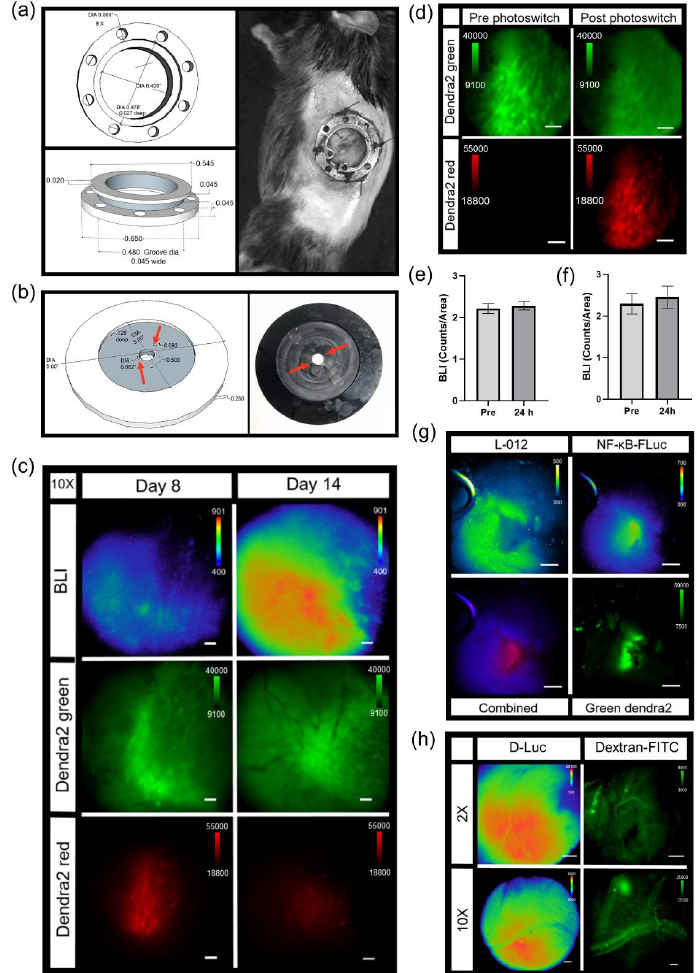
Figure 7. Intravital bioluminescence and fluorescence microscopy of pancreas window chamber. Diagram with measurements and representative photograph of ( a ) pancreas window chamber and ( b ) imaging stage insert. ( c ) Intravital microscopy images of the pancreas using wild type C57BL/6 abdominal window chamber-bearing animals with Pan02 NF- κ B-FLuc Dendra2 pancreatic tumors. Representative intravital image of NF- κ B-FLuc bioluminescence and Dendra2 fluorescence of Pan02 pancreatic tumor progression over time at 10X objective (BLI, 10 min acquisition, open filter; Dendra2 green, GFP cube, 200 ms exposure; Dendra2 red, DsRed cube, 500 ms; scale bar represents 100 µ m). ( d ) Representative fluorescence image of Pan02 tumor pre- and post-photoswitching (DAPI cube, 10 min exposure) at 10X objective (Dendra2 green, GFP cube, 200 ms exposure; Dendra2 red, DsRed cube, 500 ms; scale bar represents 100 µ m). Quantification of NF- κ B-FLuc bioluminescence counts of ( e ) total tumor and ( f ) photoconverted area of the tumor pre- and 24 h post-Dendra2 photoconversion (data are represented as mean ± SEM, n = 3 animals). ( g ) Representative intravital images of resolved bioluminescence of L-012 innate immune cell activity and Pan02 NF- κ B-FLuc reporters (2X objective, sequential imaging of L-012 (20 min acquisition, open filter) and NF- κ B-FLuc (10 min acquisition, open filter)), overlaid image of bioluminescent reporters (combined; pseudocolored red), and tumor Dendra2 (Dendra2 green, GFP cube, 2 s exposure); scale bar represents 1000 µ m. ( h ) Representative intravital images of abdominal window chamber implanted at week 14 visualizing the pancreas of KPC-Luc animals at 2X (FLuc, 2 min acquisition, open filter; scale bar represents 1000 µ m) and 10X (FLuc, 2 min acquisition, open filter; scale bar represents 100 µ m); n = 2 animals. Pancreas tumor growth monitored by FLuc bioluminescence following D-luciferin injection. Vasculature imaged post i.v. injection of dextran-FITC (200,000 MW, 4 mg/mL, epifluorescence: GFP cube; 2X, 5 s exposure; 10X, 2 s